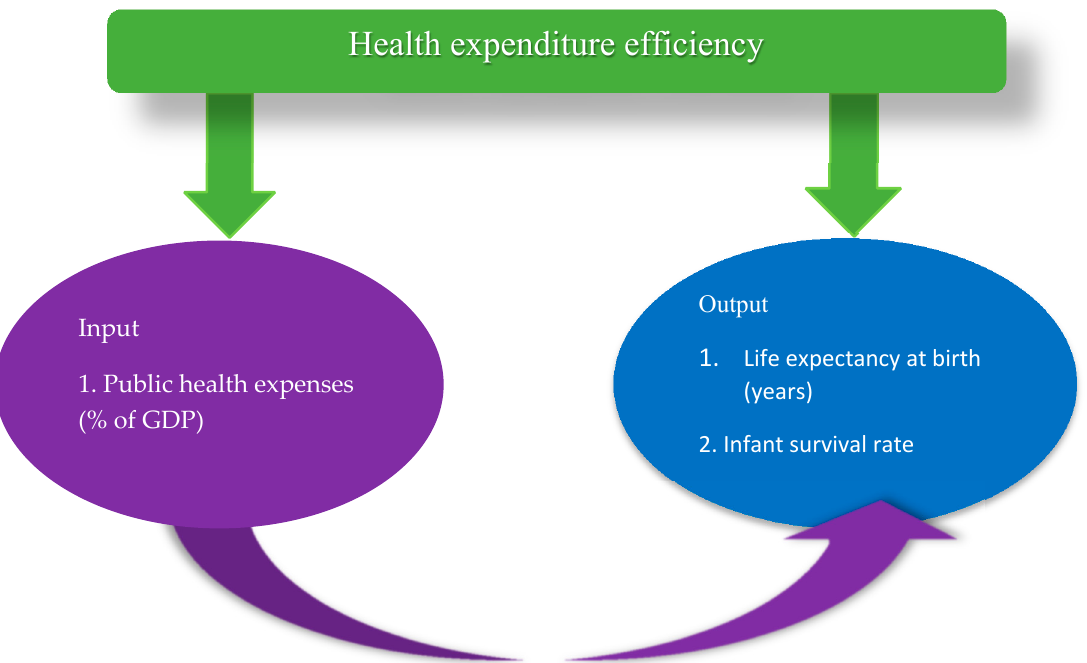
Figure 1. Inputs and output indicators of health cost efficiency among emerging economies. Source: Authors computation